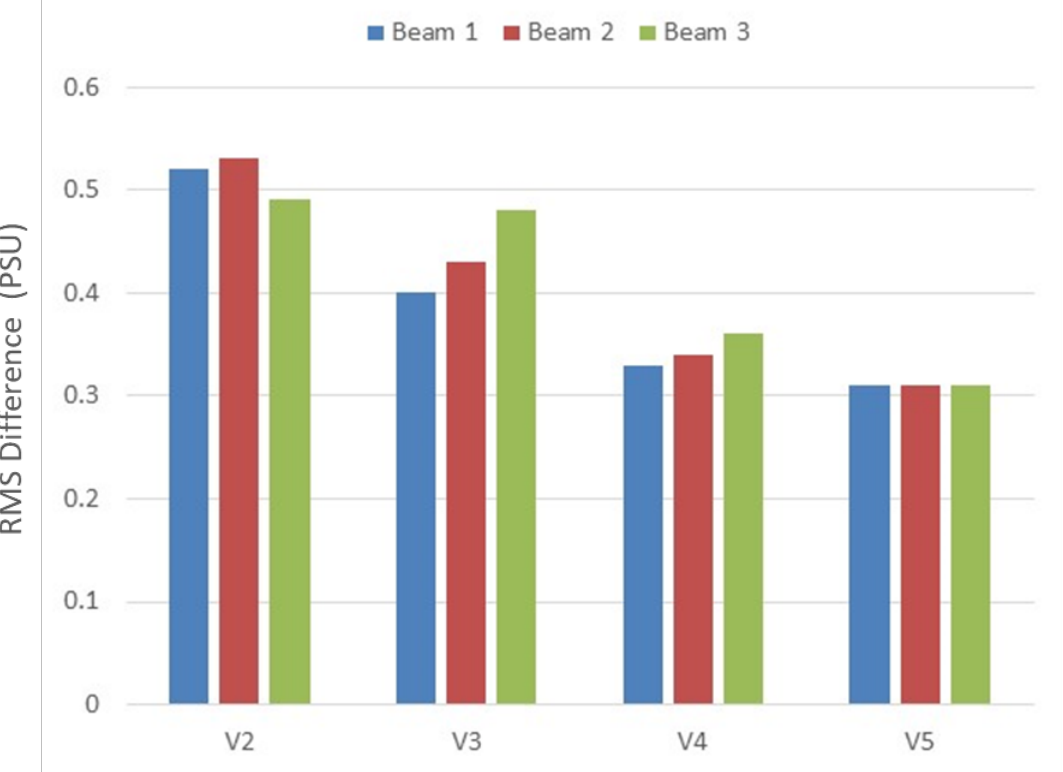
Figure 2. The root mean square (RMS) difference between Aquarius-retrieved sea surface salinity (SSS) and in situ ocean observations. The three bars in each group represent the three Aquarius beams. The groups are for different versions of the retrieval algorithm from Version 2 to the final Version 5. The data are from Figure 3 in Kao et al.